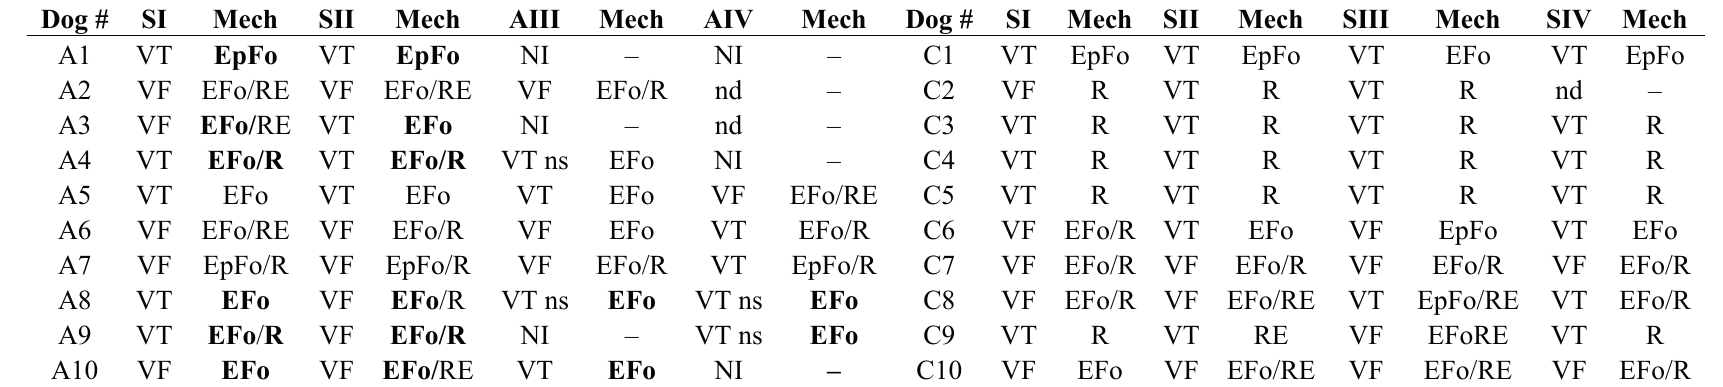
Table 2. Apocynin (APO) group details.